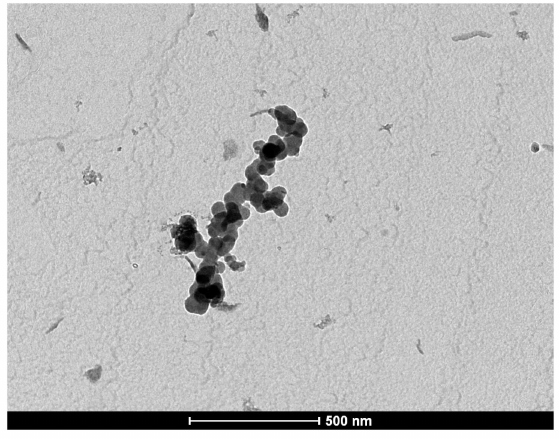
Figure 1. TEM image of polymeric micelles loaded with magnetic NPs. Scale bar = 500